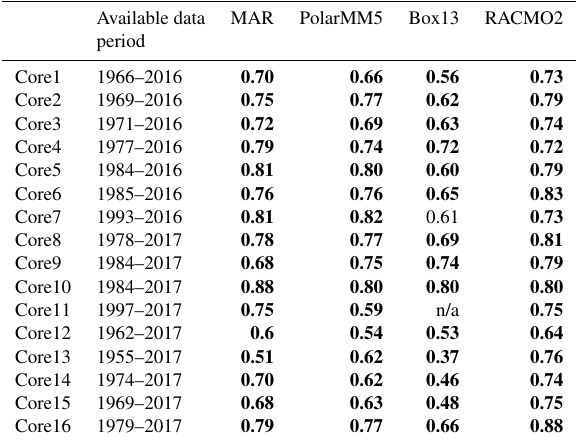
Table 2. Pearson correlation coefficients between accumulation rate time series from firn cores and co-located RCM output over their common time period ∗ . Available